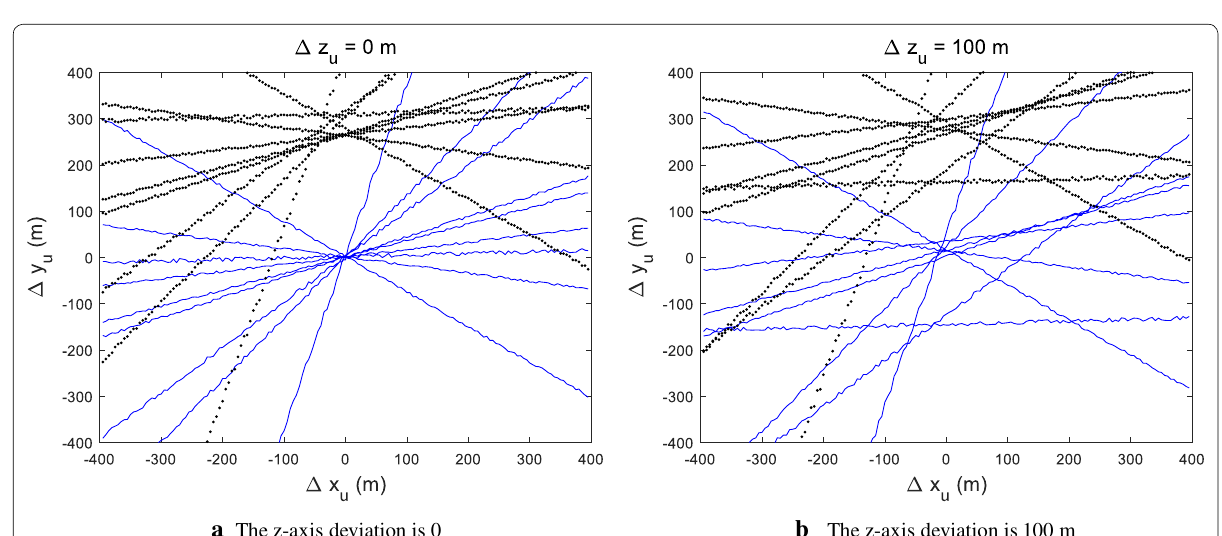
a The z-axis deviation is 0 b The z-axis deviation is 100 m Fig. 3 Lines corresponding to different signals in the search plane. Blue lines correspond to authentic signals and black lines correspond to spoofing